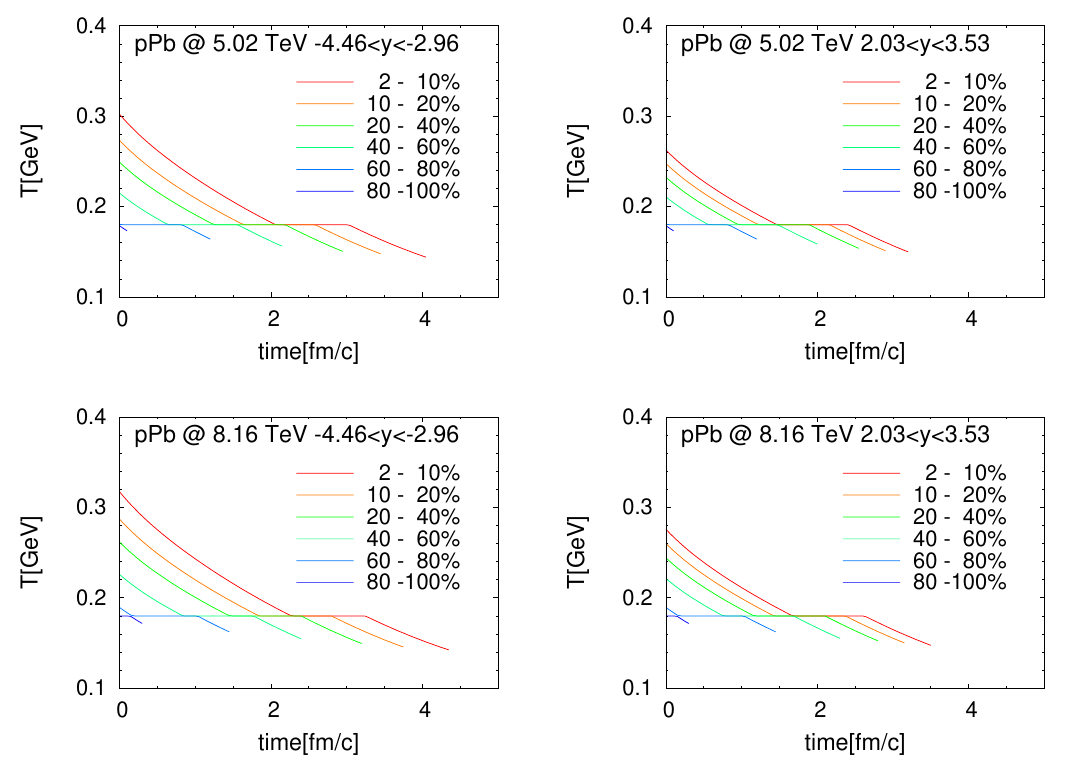
Figure 2 . Temperature evolution from the elliptic (cid:12)reball model for di(cid:11)erent centralities in p -Pb collisions at 5.02 TeV (upper panels) and 8.16 TeV (lower panels) at backward (left column) and forward (right column)